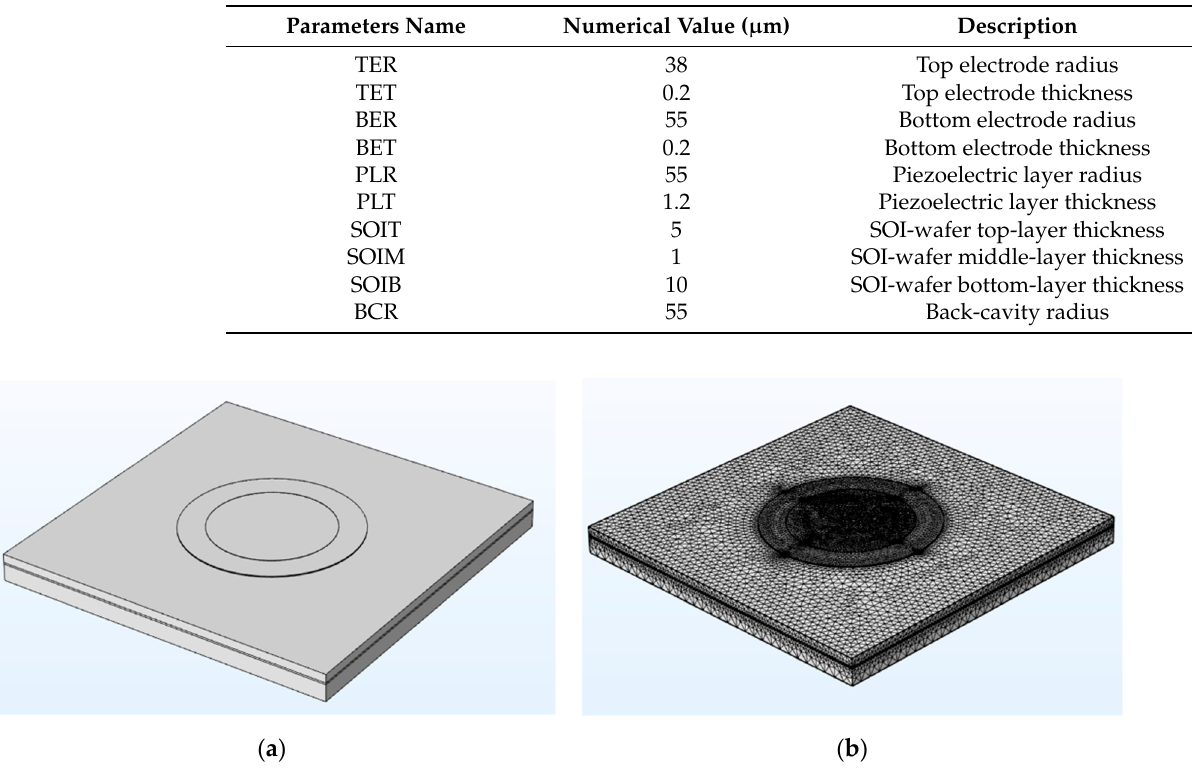
Figure 3. ( a ) PMUT array element structure geometric model; ( b ) meshing of PMUT geometric models.